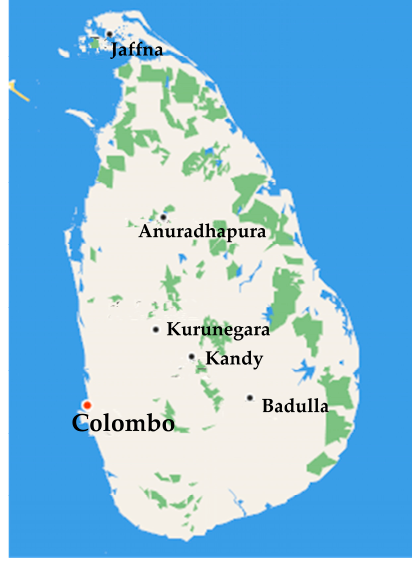
Figure 9. Map of Sri Lanka.